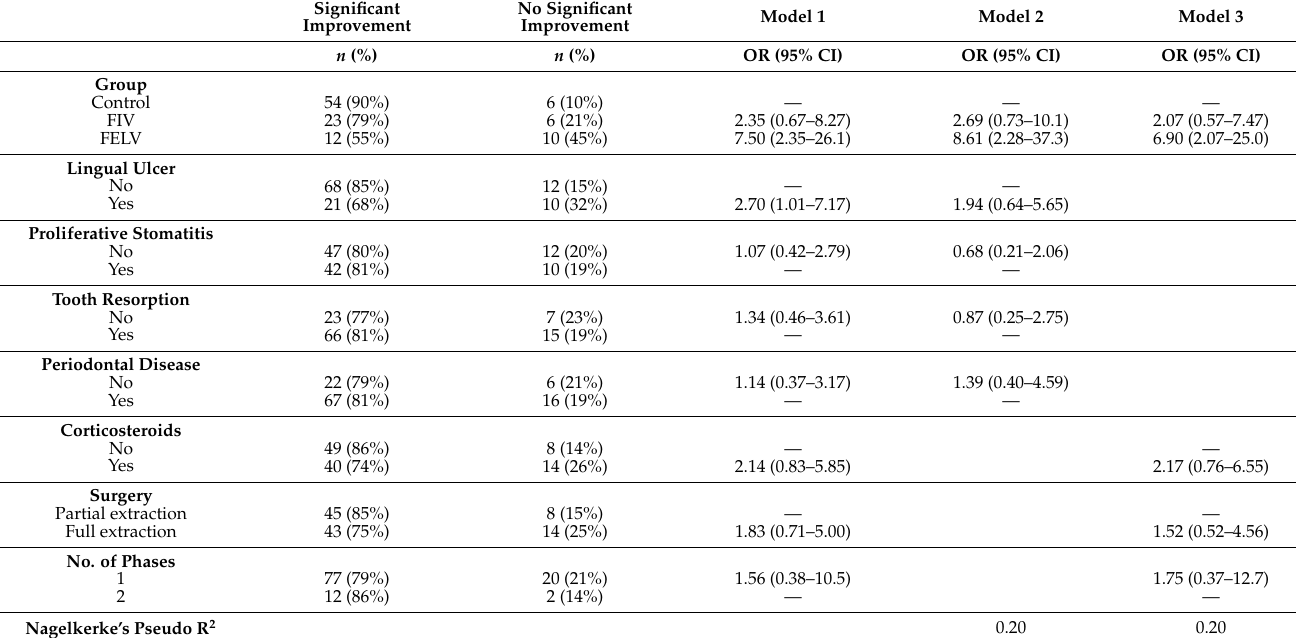
Table 6. Logistic regression models considering “No significant improvement” as the event of interest.